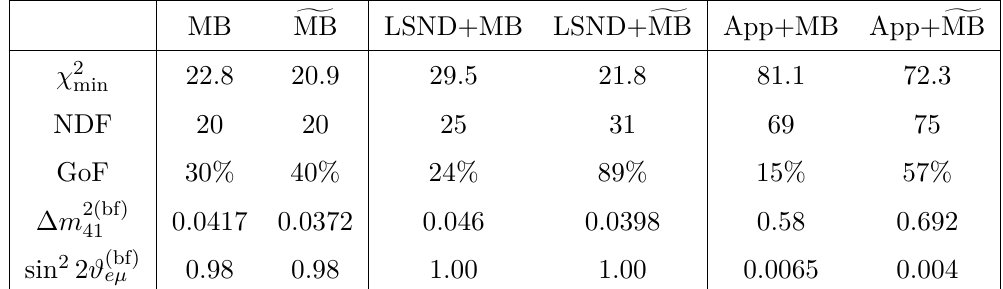
and sin 2 2 ϑ (bf) eµ are the 41